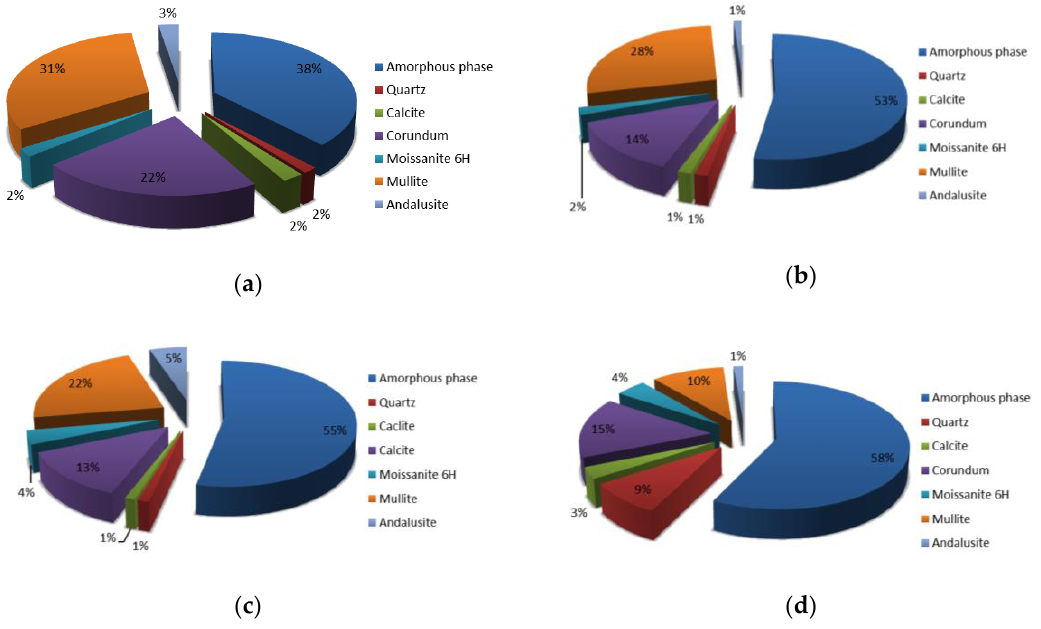
Figure 5. Rietveld refinement of precursor’s fraction ( a ) above 4 mm, ( b ) between 2 mm and 4 mm, ( c ) between 1 mm and 2 mm and ( d ) below 1